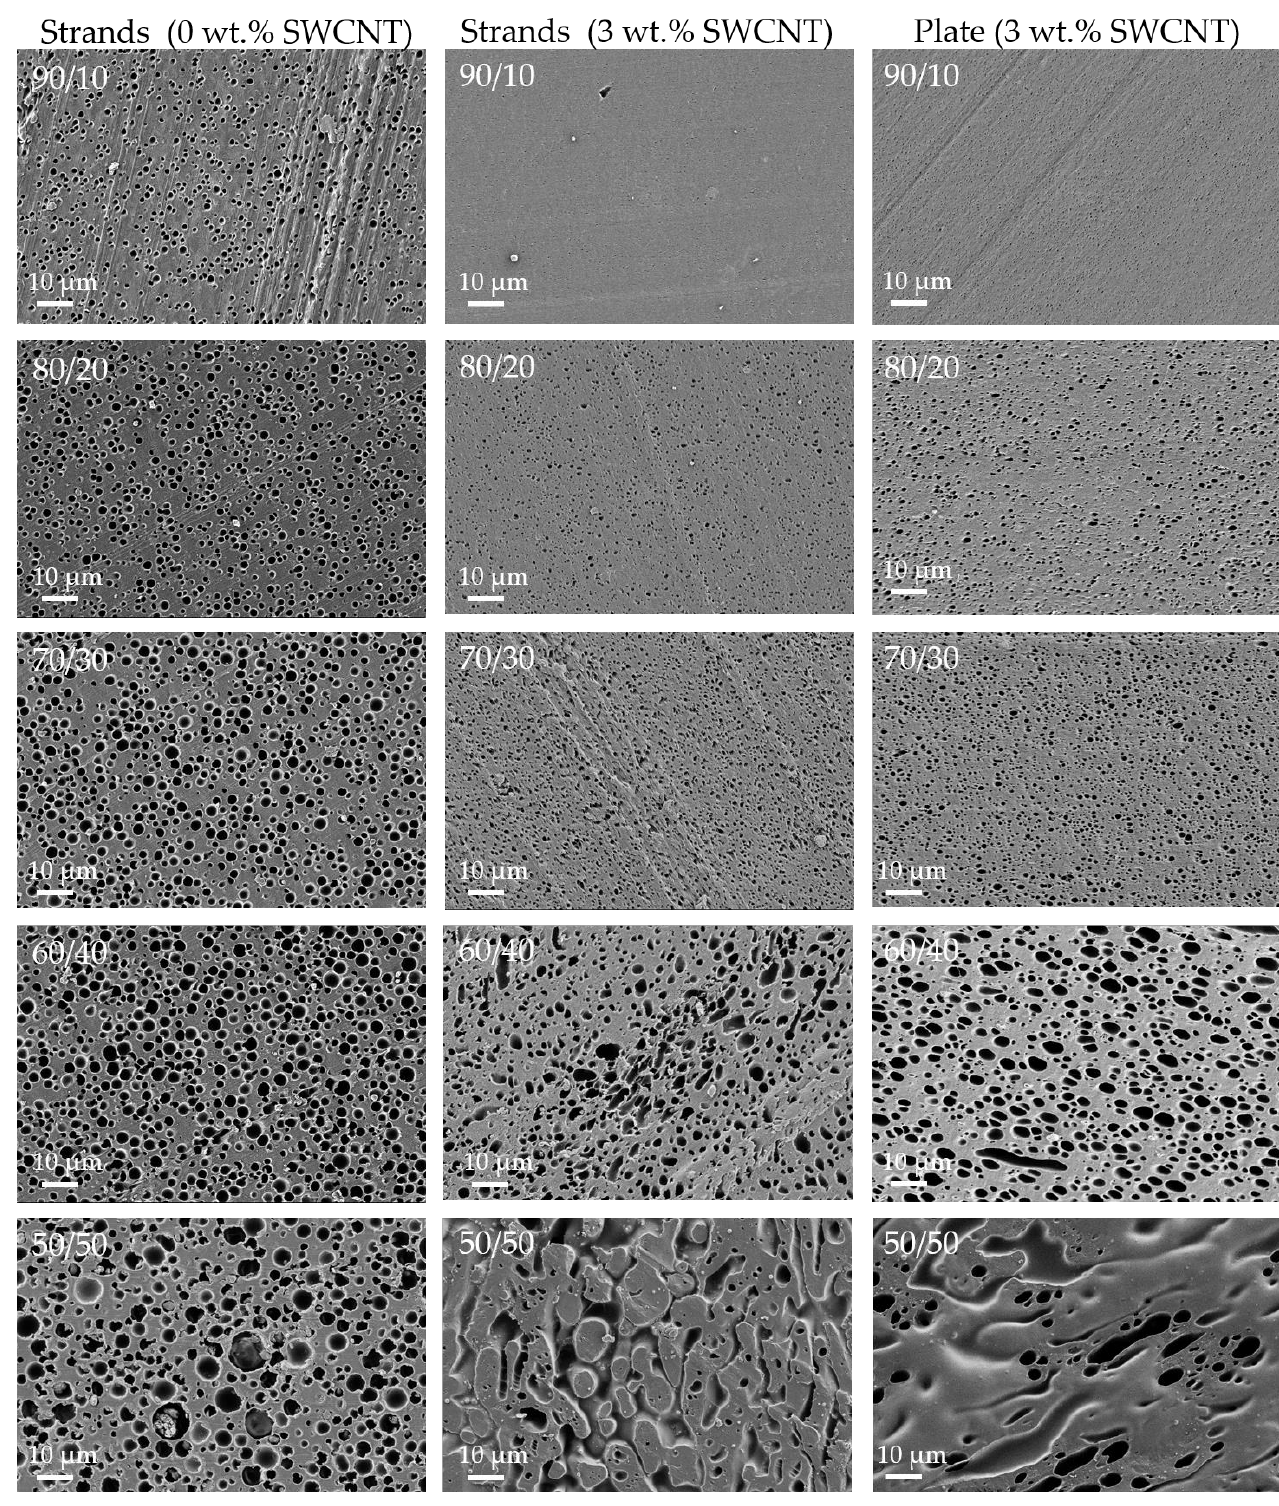
Figure 8. SEM images of etched flat surfaces of PA6/PMMA blends with different blend ratio from 90/10 ( first line ) up to 50/50 ( last line ) and different kinds of sample such as strands without CNTs ( left ), strands with 3 wt.% CNTs ( middle ), and compression-molded plates with 3 wt.% CNTs ( right ).